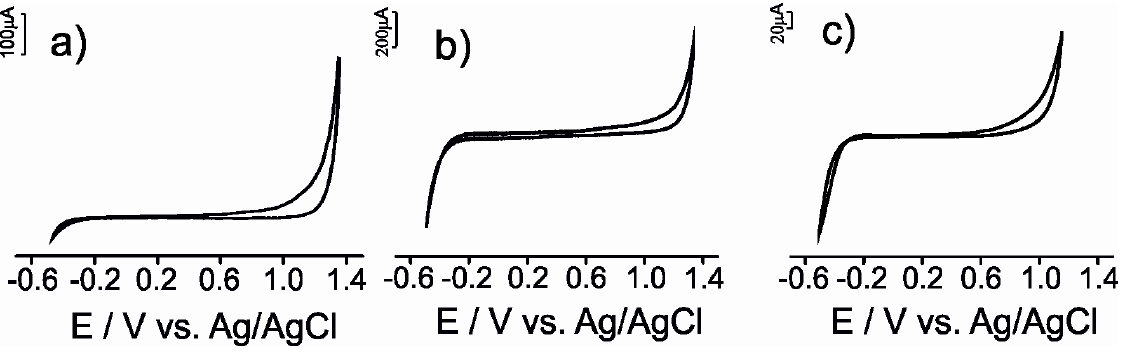
Figure 3. The voltammetric responses of G-CPE (a) ;  S-CPE (b) and CNT-CPE (c) immersed in aqueous 0.1 mol·L −1 KCl